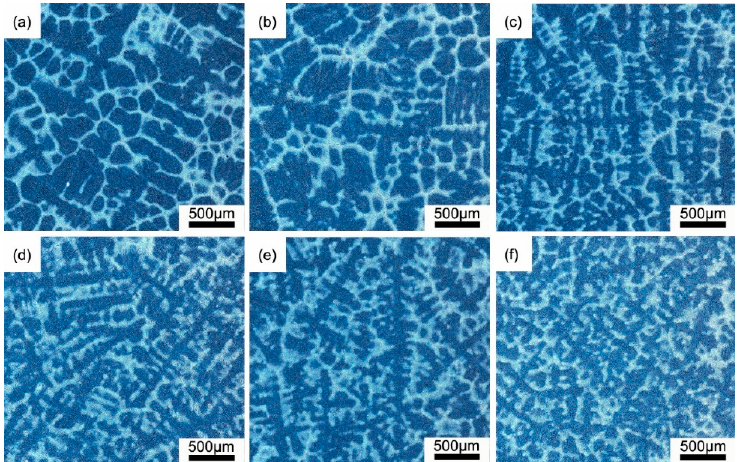
Figure 5. Microstructure of the H13 ESR ingot observed by optical microscopy: ( a ) sample S1, ( b ) sample S2, ( c ) sample S3, ( d ) sample S4, ( e ) sample S5, and ( f ) sample S6 (online version in color).